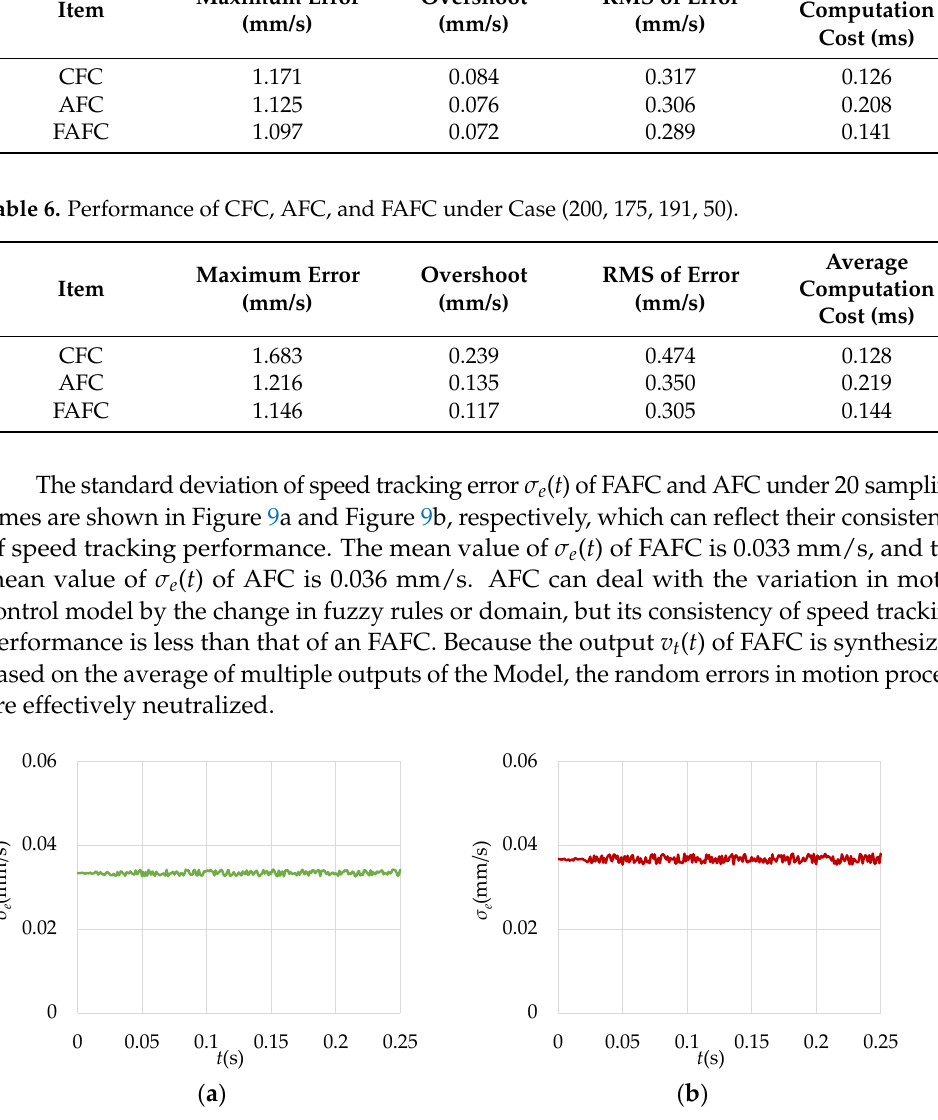
Table 6. Performance of CFC, AFC, and FAFC under Case (200, 175, 191, 50).